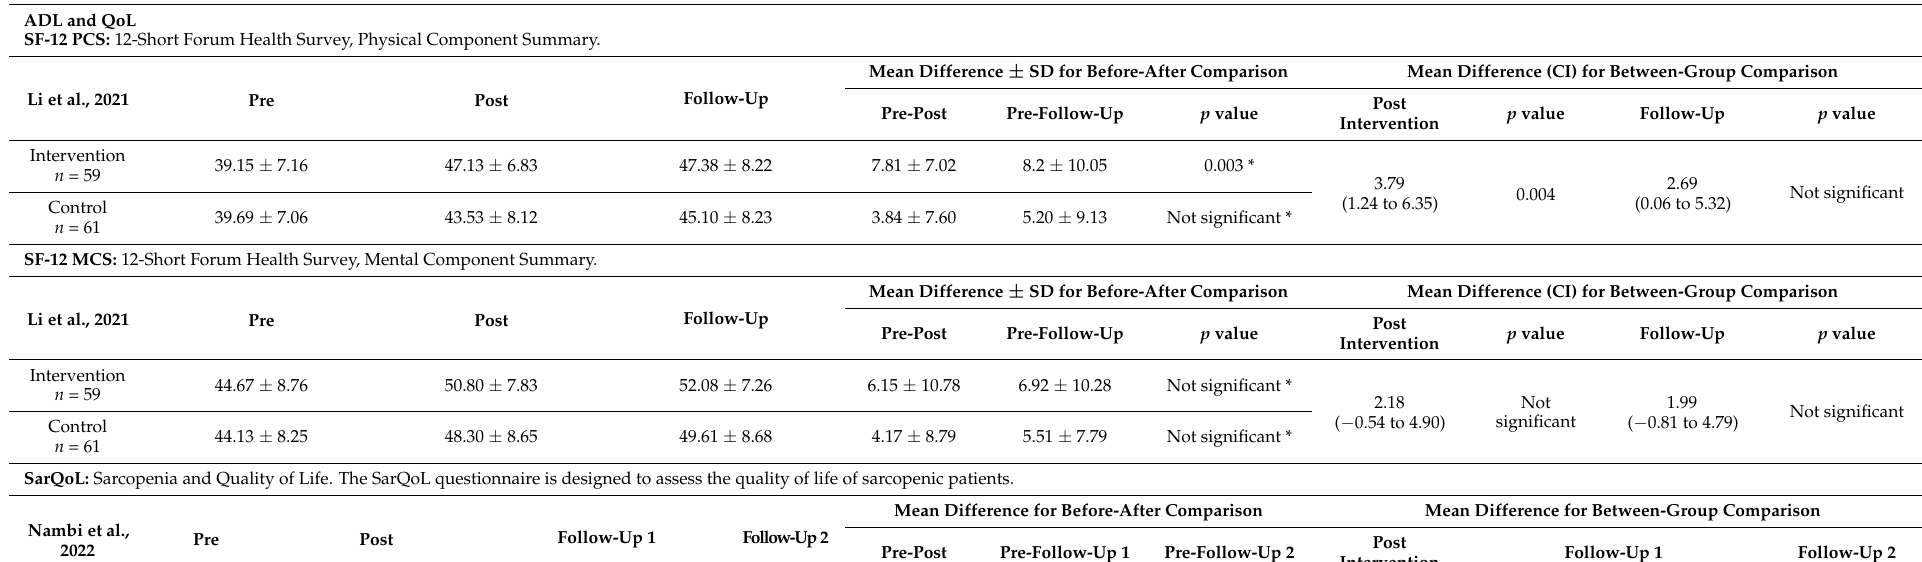
Table 4. Quality of life and independence outcomes. QUALITY OF LIFE AND INDEPENDENCE